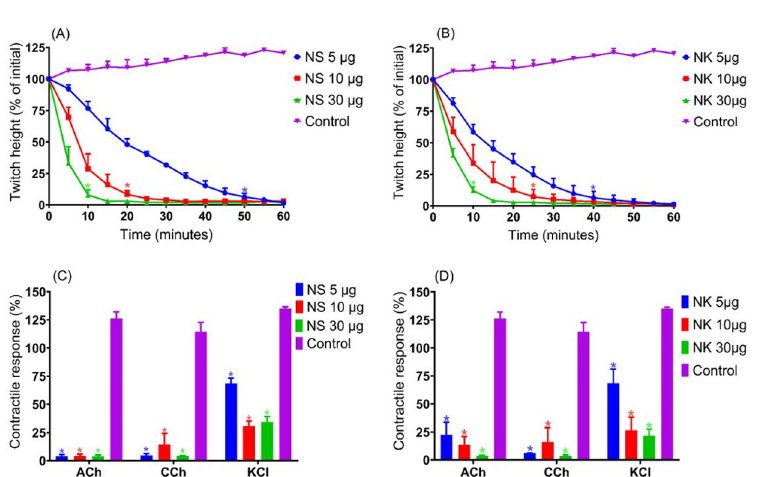
Fig 4. Neurotoxic effects of Malaysian N . sumatrana venom and N . kaouthia venom in indirectly stimulated twitches of the chick biventer cervicis nerve-muscle preparation. Panels (A) and (B) indicate change of indirectly stimulated twitch height in tissues exposed in different concentration (5–30 μ g/ml) of N . sumatrana and N . kaouthia venoms, respectively. Panels (C) and (D) indicate change in the contractile response to exogenous agonist in tissue exposed to different concentration (5–30 μ g/ml) of N . sumatrana and N . kaouthia venoms, respectively. NS indicates N . sumatrana venom and NK indicates N . kaouthia venom � p < 0.05, significantly different from control (distilled water) (n = 3, one-way ANOVA).